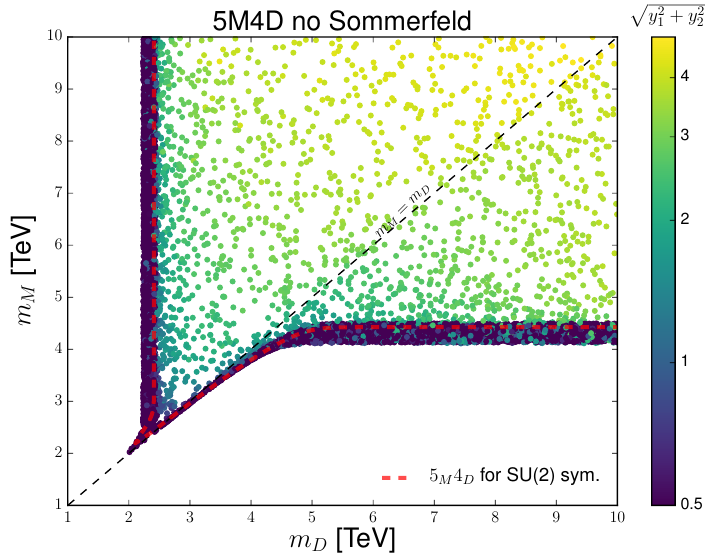
Figure 8. DM candidate parameter space in the perturbative 5M4D case for an explicit integration of the dark matter abundance with micrOMEGAs in the SU(2) L -broken limit. All points give rise